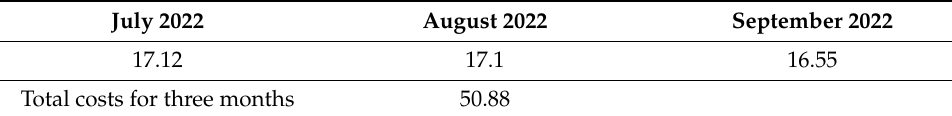
Table 5. Monthly costs in Euros ( € ) of AWS Services/Kinetic for one SIM